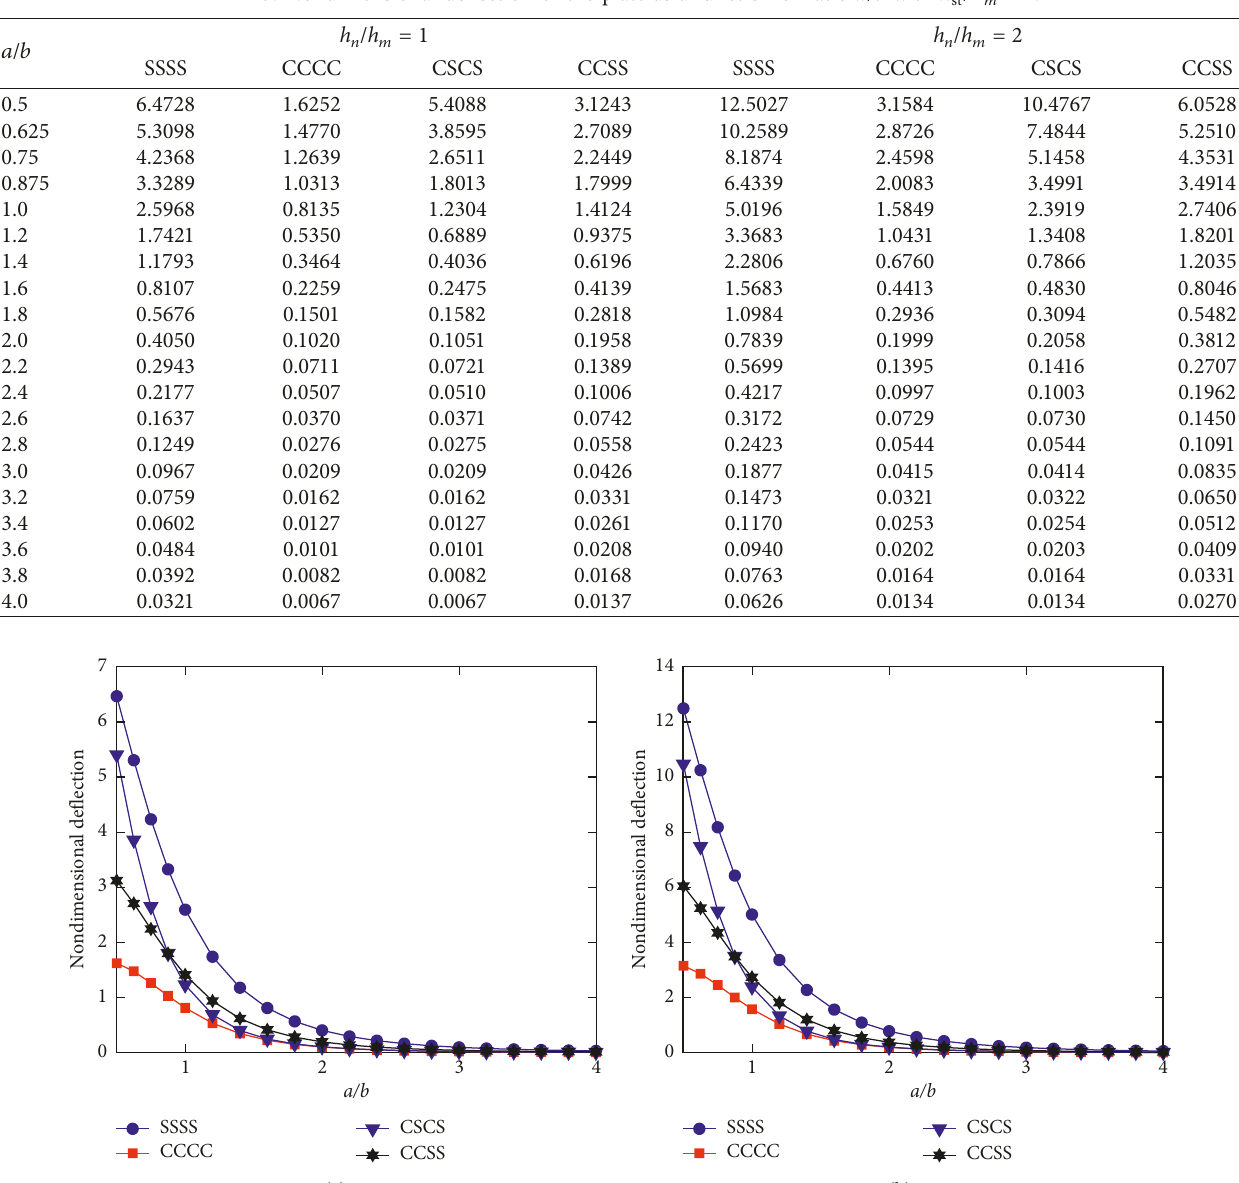
Table 3: Nondimensional deflection of the plate as a function of ratio a / b with k